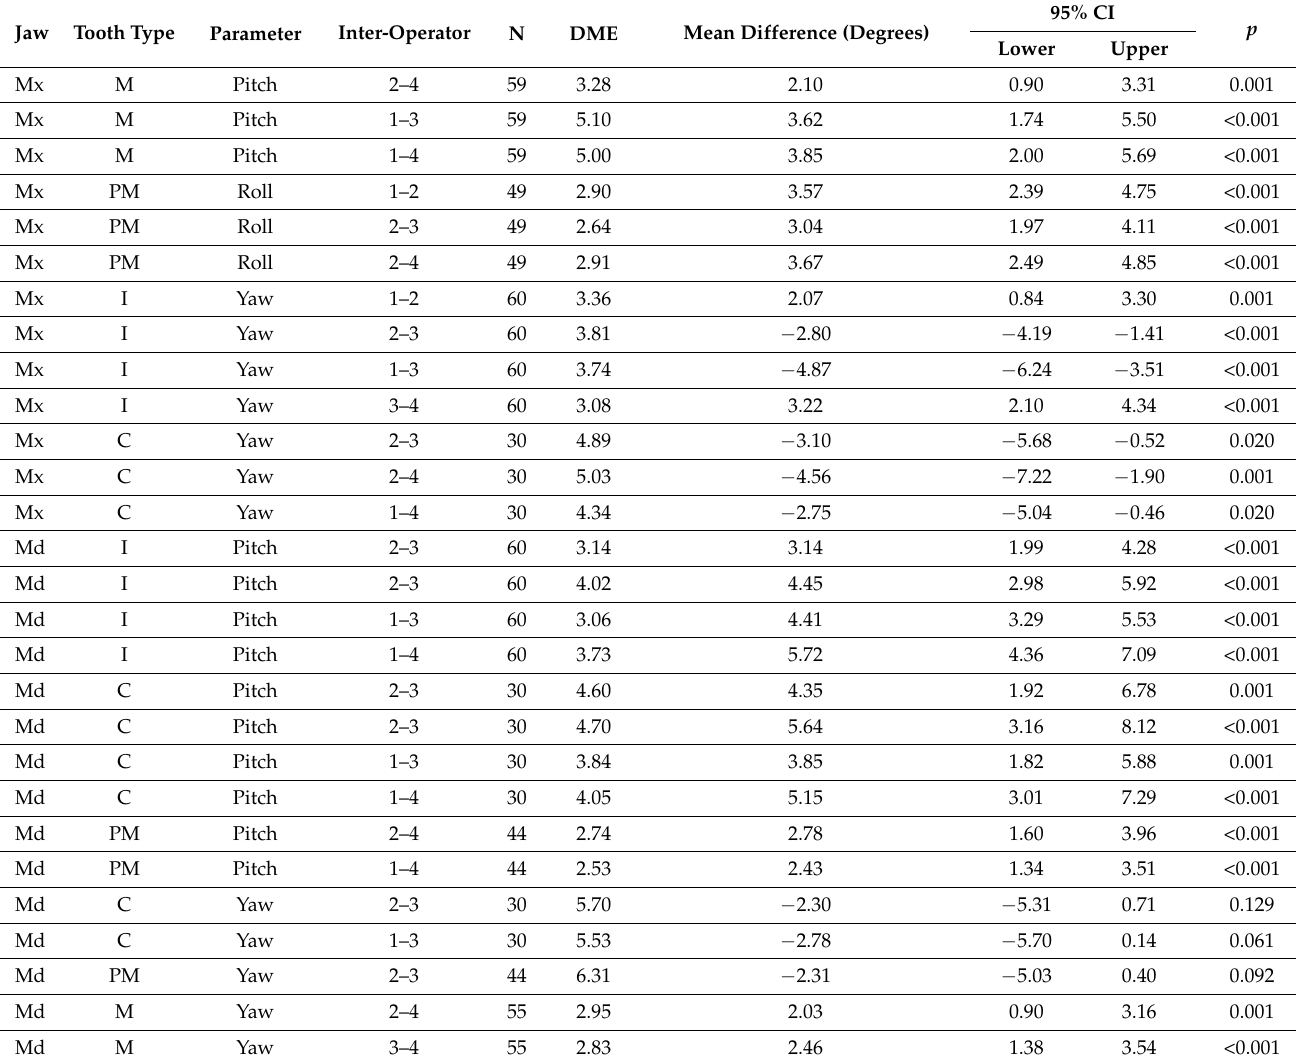
Table 2. Inter-operator mean differences, 95% confidence interval (CI), DME values, and result of the paired sample t test ( p value) for differences in rotations larger than 2 degrees in the maxilla and